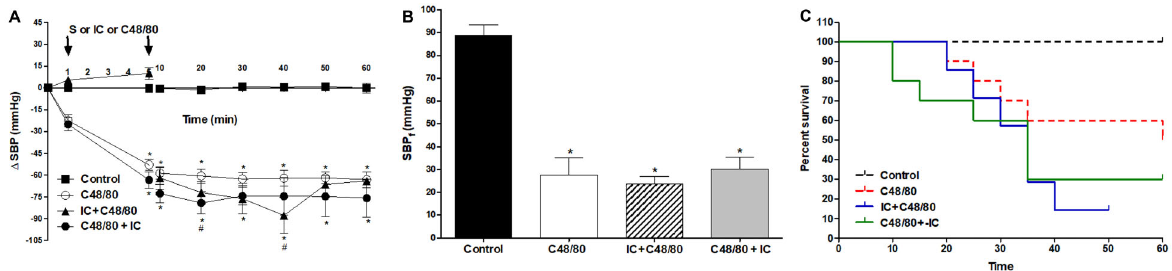
Figure 5. A , Systolic blood pressure (SBP), B , fi nal systolic blood pressure (SBP f ), and C , survival measurements (Kaplan-Meier; n=6) of rats that received C48/80 and/or IC. Data are reported as mean ± SE. A : *P o 0.001 C48/80, C48/80 + IC, IC + C48/80 vs control;